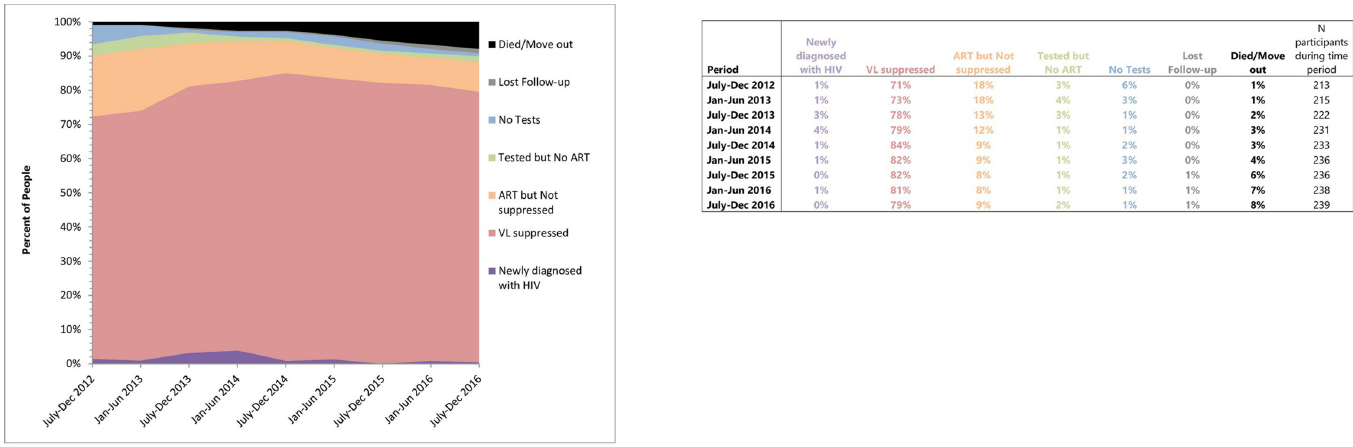
Fig 1. Cascade of care for gbMSM living with HIV in the Momentum Health Study